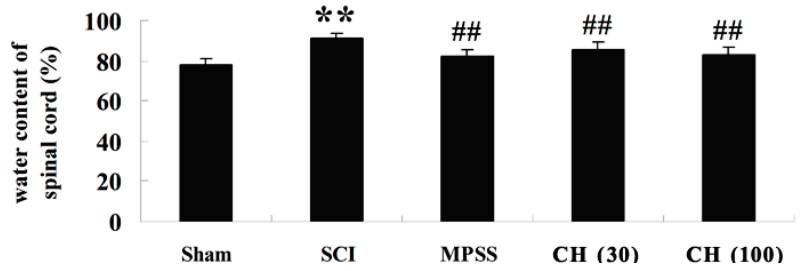
Figure 2. CH diminishes the water content of spinal cord after SCI ( n = 10, mean ± SD). ** p < 0.01 compared with the sham group; ## p < 0.01 compared with the SCI group. Sham, sham group; SCI, spinal cord injury group; MPSS, methylprednisolone-treated; CH (30), chrysin (30 mg/kg)-treated; CH (100), chrysin (100 mg/kg)-treated